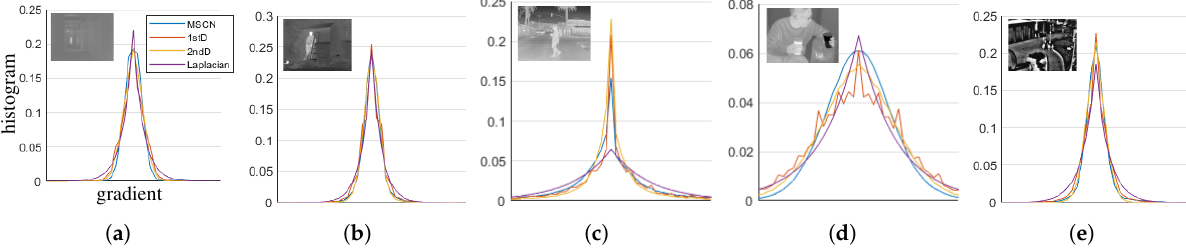
Figure 3. Distribution derived from the high-frequency of LWIR images. The statistics of the high-frequency is derived with three filters, MSCN, the first and the second derivatives. The three filtered signals demonstrate similar distributions.